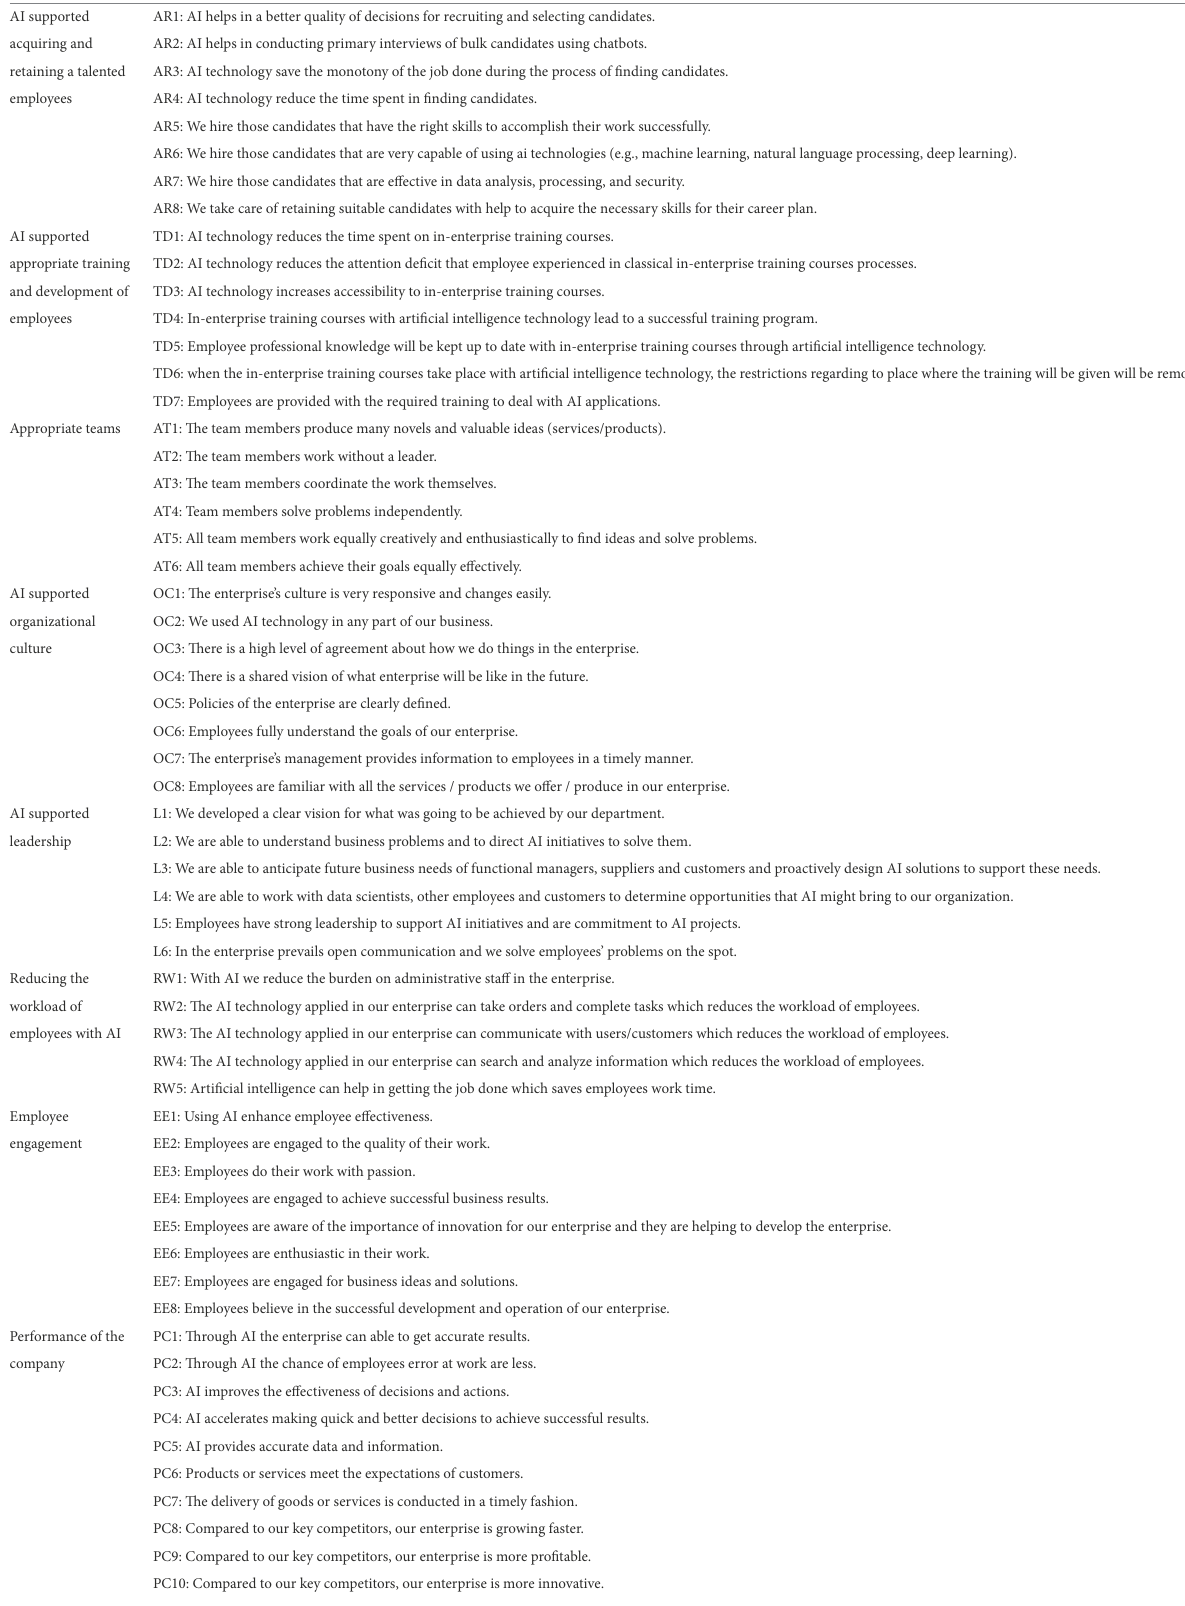
TABLE 1 Items for each construct.